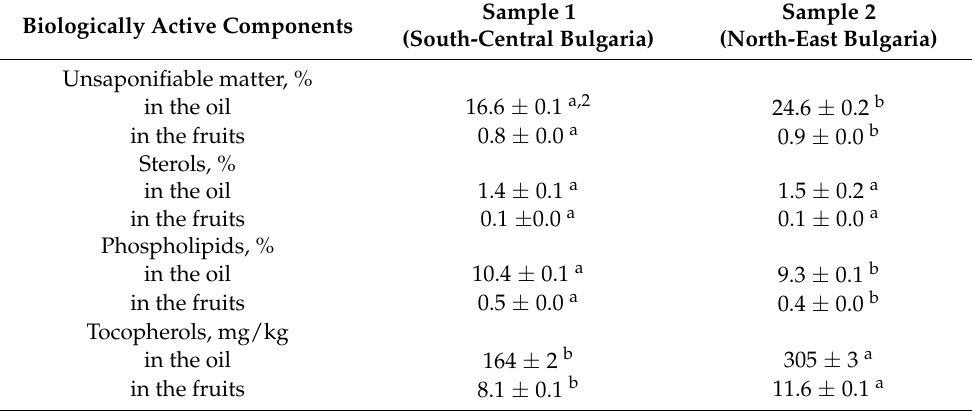
Table 4. Total content of unsaponifiable matter, sterols, phospholipids and tocopherols in the veg- etable oils from the fruits 1 .